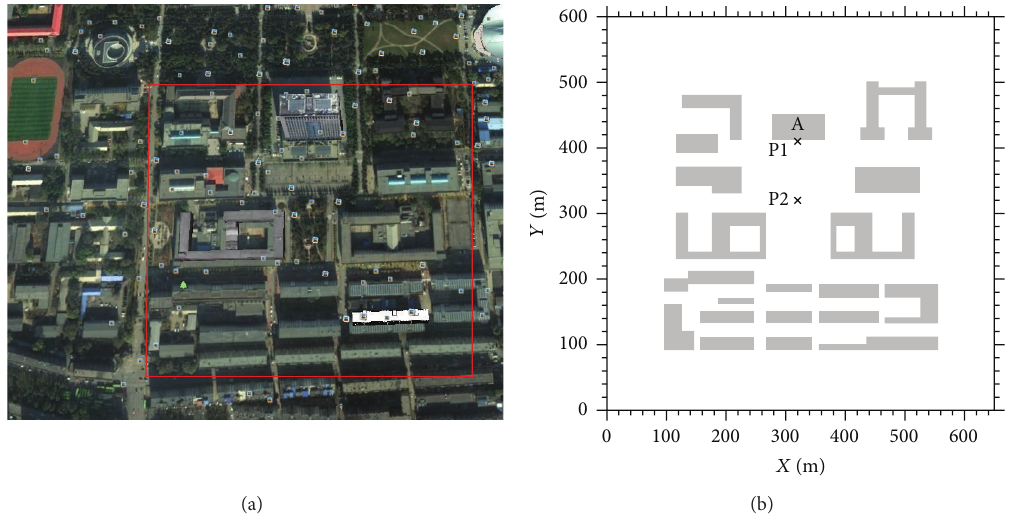
Figure 2: Google Earth image and the horizontal plane of the CFD computation domain: (a) Google Earth image of Northeastern University; (b) the horizontal plane of the CFD computation domain at 𝑧 = 2.5 m. The red rectangle in (a) indicates the CFD domain; the crosses labeled by P1 and P2 in (b) indicate the locations of point sources.